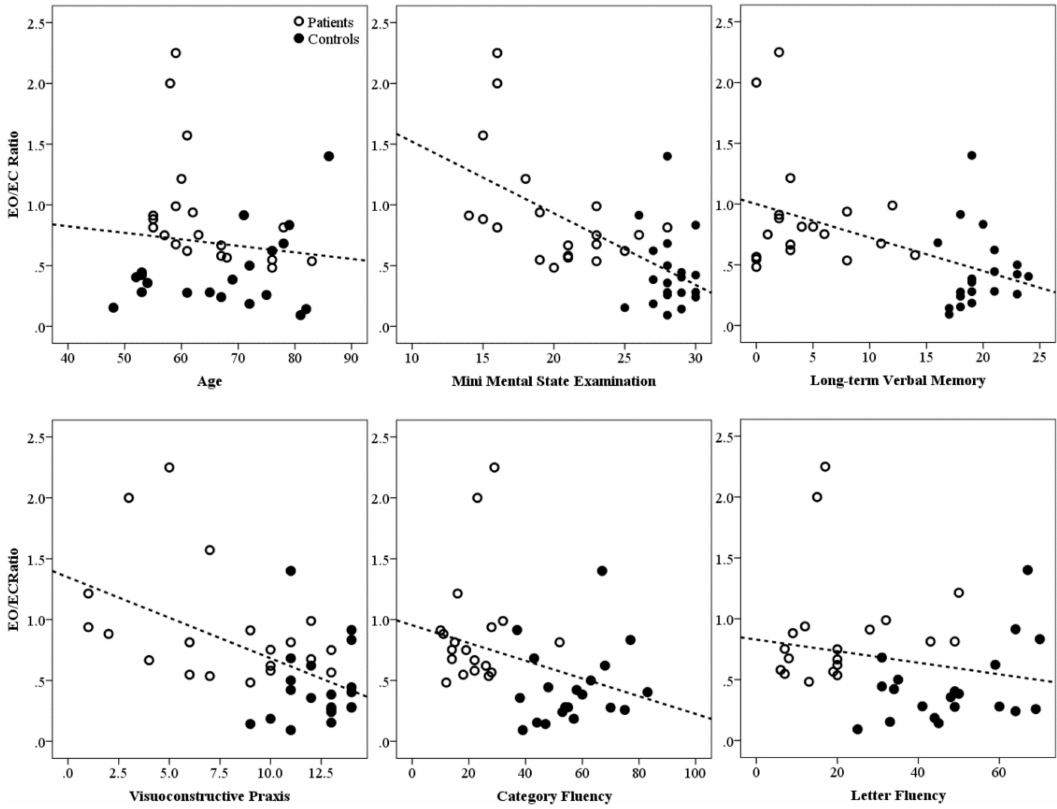
Figure 6. Electroclinical (neuropsychology) correlations. Relationship between EO/EC bi-centroparietal synchronization ratio and a series of variables, including age, general cognitive level, verbal episodic memory, visuoconstructive abilities, and verbal fluency. Although these analyses were carried out using non-parametric rank-based correlations (see Results section), a linear model was fitted for the sole purpose of visualization. The r correlations (perfectly mirroring nonparametric statistics) are as follows—Age: r = − 0.116, p = 0.475; MMSE: r = − 0.629, p < 0.001; long-term verbal memory: r = − 0.508, p = 0.001; visuoconstructive praxis: r = − 0.537, p < 0.001; category fluency: r = − 0.338, p = 0.035; letter fluency: r = − 0.205, p =